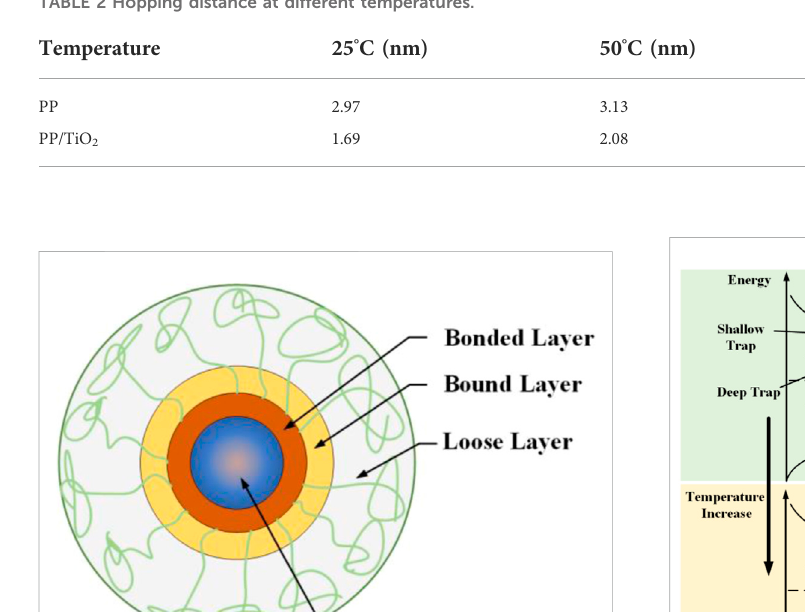
FIGURE 15 Multi-core model for nanocomposites.